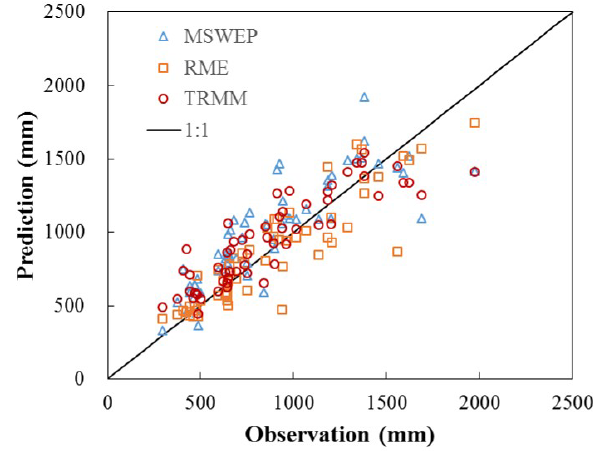
Figure 13. Comparison in mean annual precipitation between the gauged measurements and predictions by the MSWEP, RMM and RME.